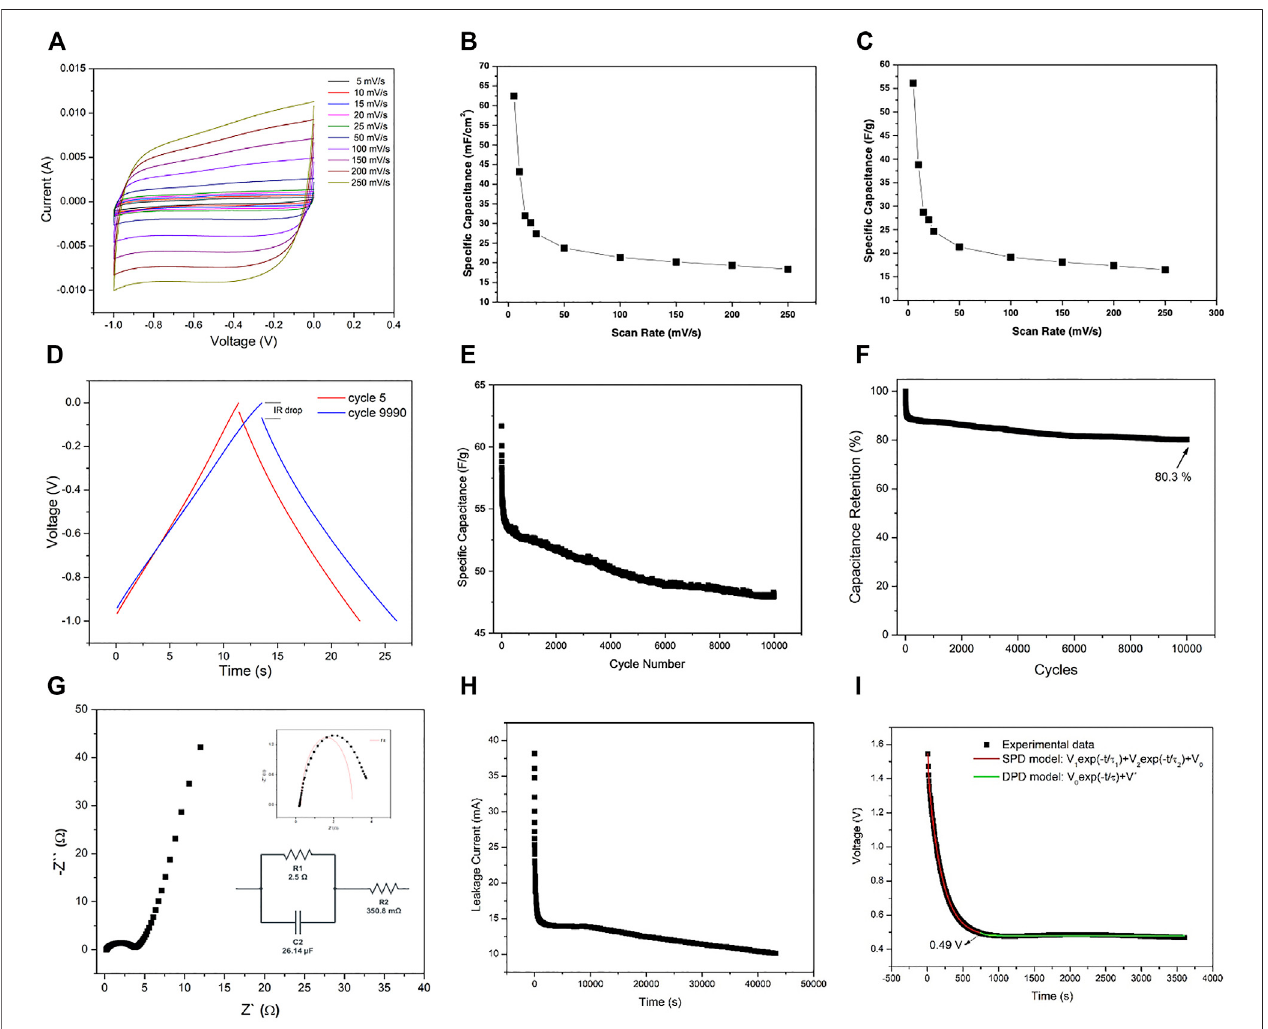
FIGURE6| CoincellperformancemeasurementoftherGO-Aubaseddevice. (A) CVcurve. (B) Arealspeci fi ccapacitanceatdifferentscanrates. (C) Massspeci fi c capacitance at (D) charge discharge curve, (E) cyclicstability, (F) capacity Retention, and (G) Nyquistplotofthe supercapacitordevice, (H) leakage current, and (I) self- discharge curves of the